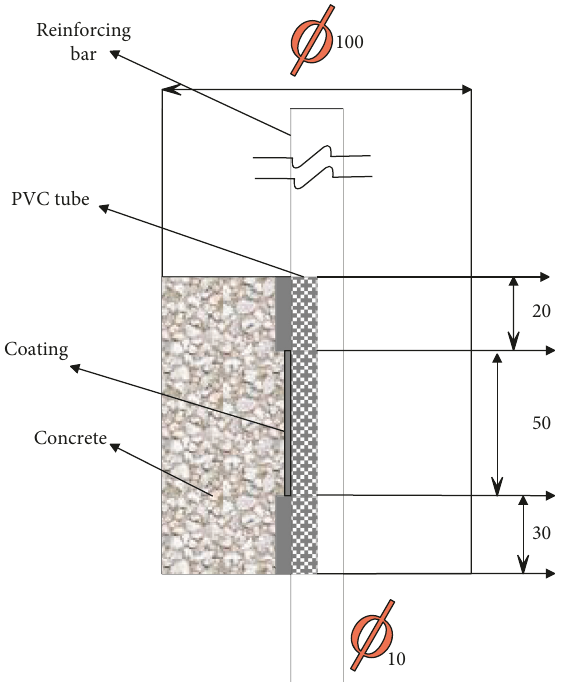
Figure 4: Reinforced concrete sample (unit: